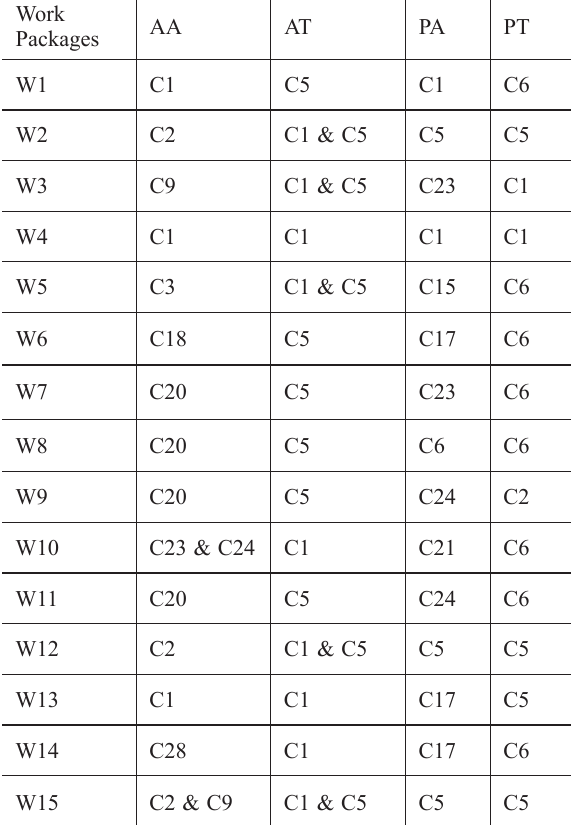
Table 4. Absolute any, absolute top, percent any, and percent top critical criteria Work AA Packages